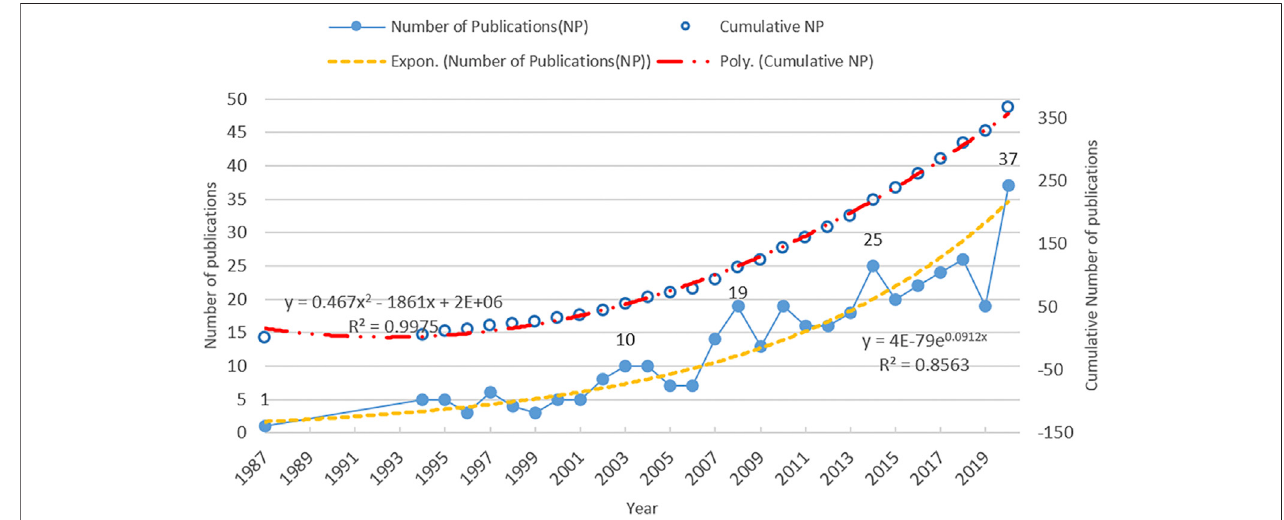
FIGURE 1 | Annual distribution of Coptis research output.